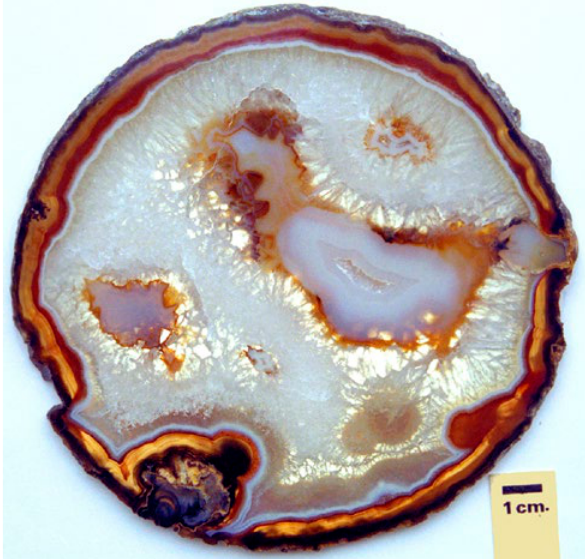
Figure 26. The fine concentric bands of ferric hydroxide stained chert, the growth of coarse crystals into the crystal cavities in the centre and the fluid ‘out-burst’ channel in this geode are positive evidence for the syneresis of its precursor silica gel. This clear empi- rical evidence positively supports theoretical work that shows that synerectic aging of a uniformly mixed gel must result in separation of component particles into Liesegang type concretionary bands.